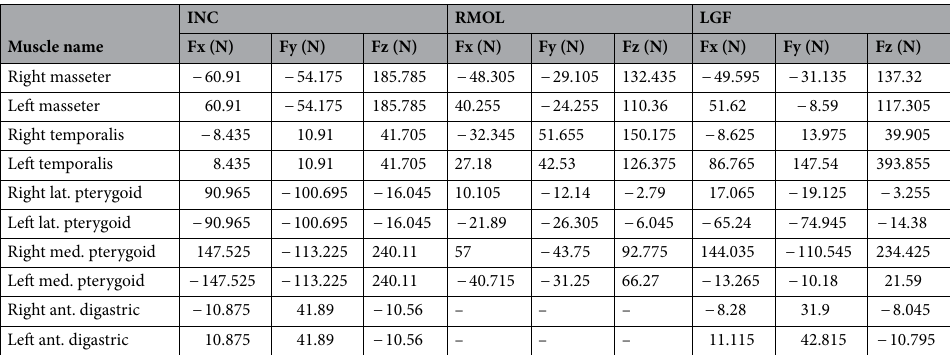
Table 1. Muscle forces for nominal incisal biting (INC), right molar (RMOL) and left group biting